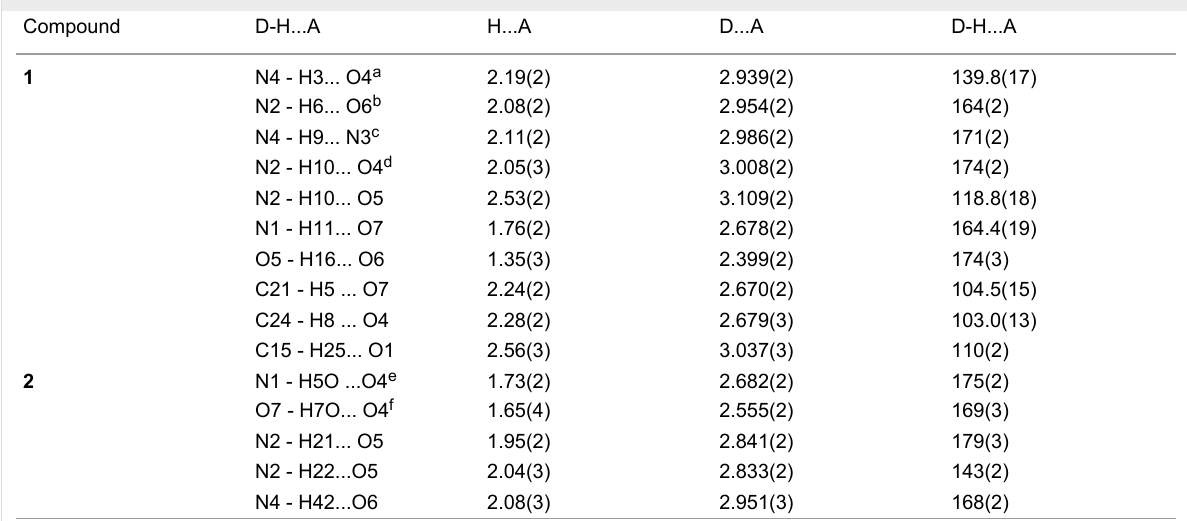
Table 2: Hydrogen bonding geometry for the compounds 1 and 2 Compound